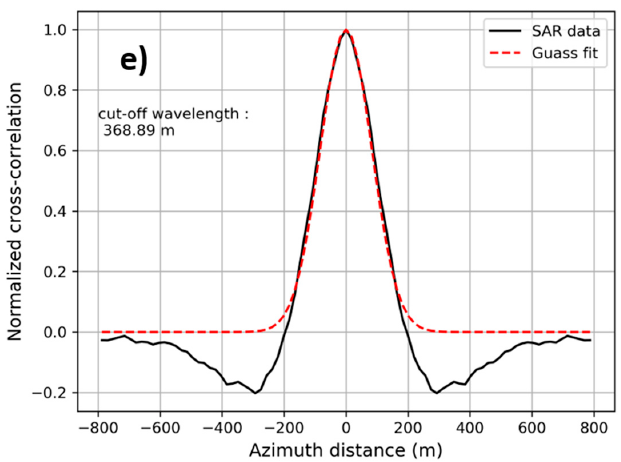
Figure 6. VV- ( a ) and VH- ( b ) polarized GF-3 WM imagettes acquired at 147.33°W/28.50°N on 31 January 2017, and the real ( c ) and imaginary ( d ) cross spectrum, with ( e ) azimuth cut-off corresponding to ( a ).